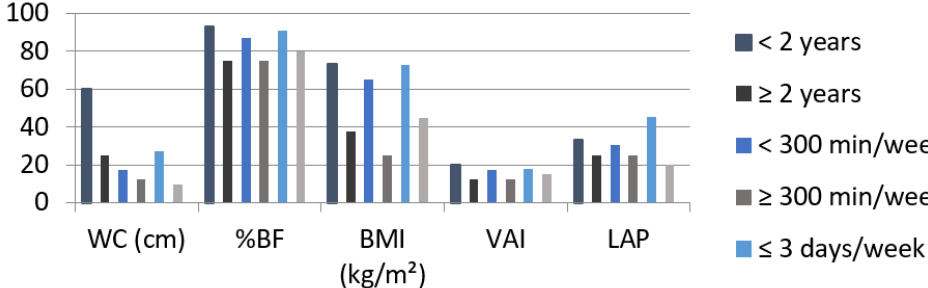
Figure 1. Frequency of inadequacy of anthropometric indices among women with resistance training time < 2 years, ≥ 2 years; <300 min per week, ≥ 300 min per week; and weekly frequency ≤ 3 days per week and >3 days per week. WC: waist circumference; %BF: body fat percentage; BMI: body mass index; VAI: visceral adiposity index; LAP: lipid accumulation product. Table 3. Association between lipid profile and metabolic phenotypes according to time in years, in minutes per week and weekly frequency of